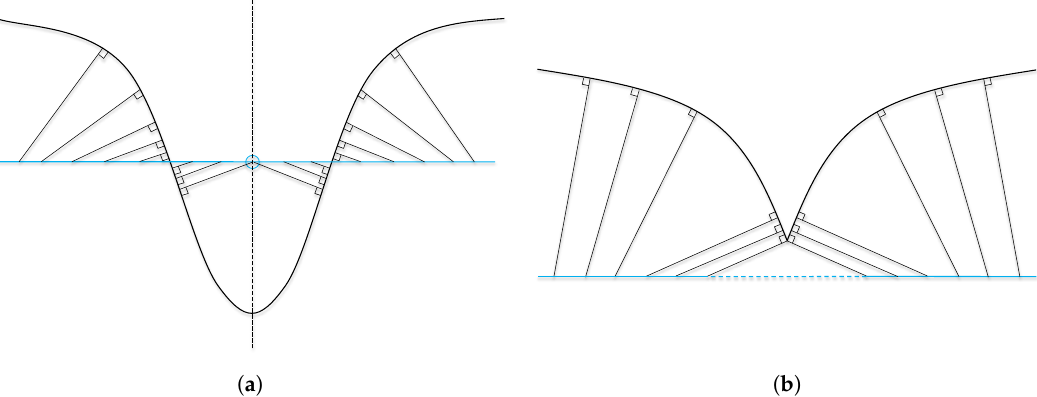
Figure 1. Special cases encountered during point projection: ( a ) Exact projection from points on a straight line to a bell-shaped curve. Discontinuity occurs at the circled central point due to non-uniqueness of point projection. ( b ) Projection from points on a straight line to a cone-shaped curve. The dashed line segment has no footpoint on the